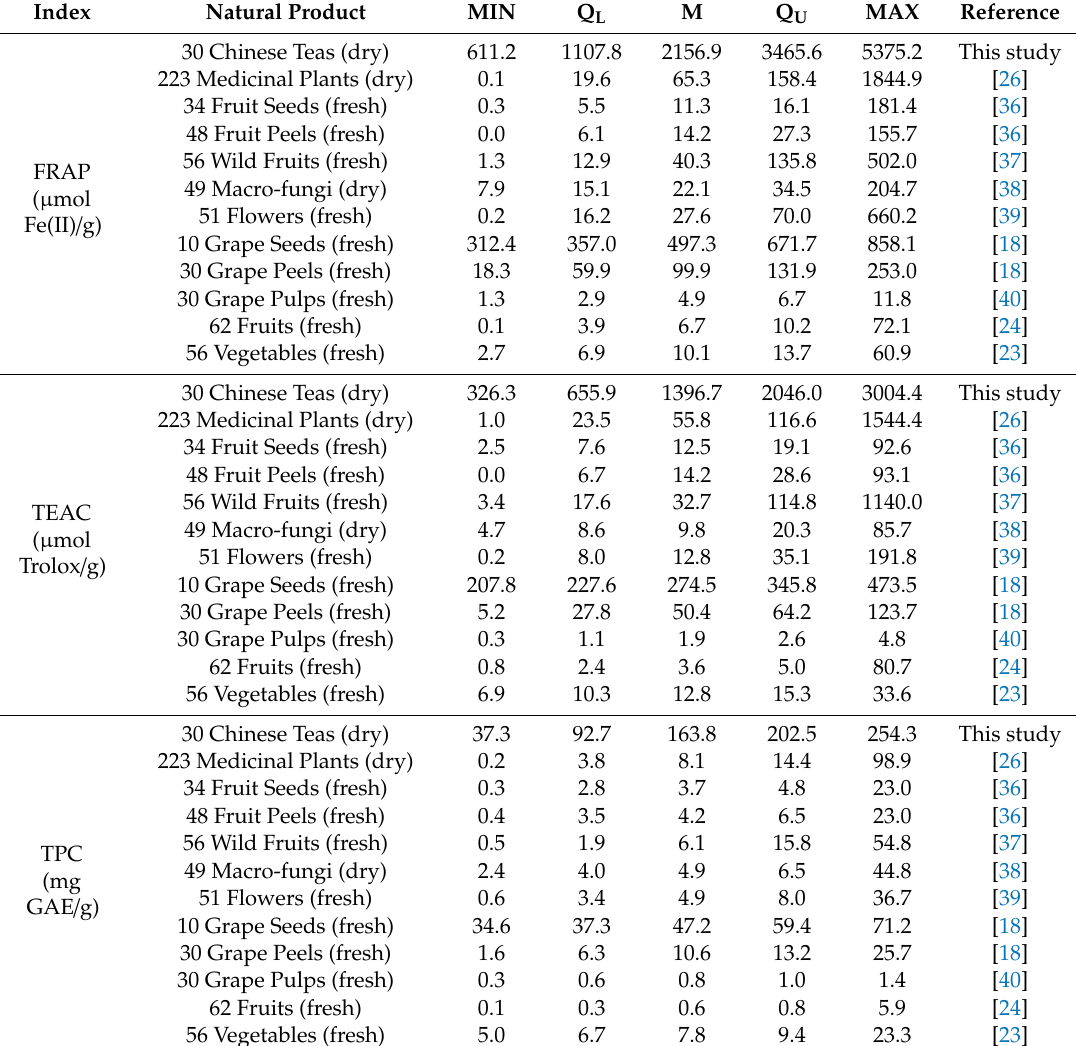
Table 9. Comparison among natural products regarding FRAP, TEAC, and TPC